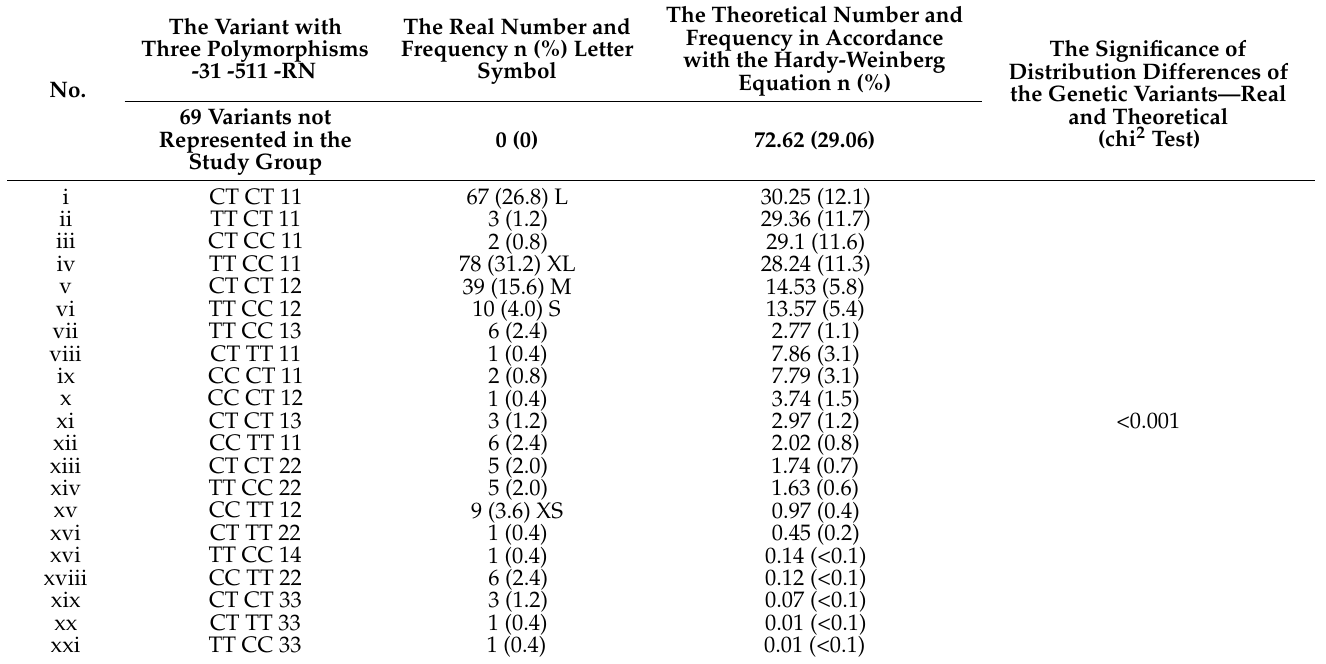
Table 6. The observed frequency of occurrence of the variants of three polymorphisms with the frequency resulting from the Hardy-Weinberg equation with the assessment of the significance of differences.